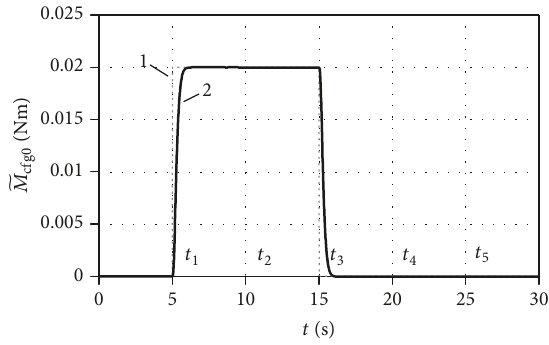
̃𝑀 value by proposed FI cfg 0